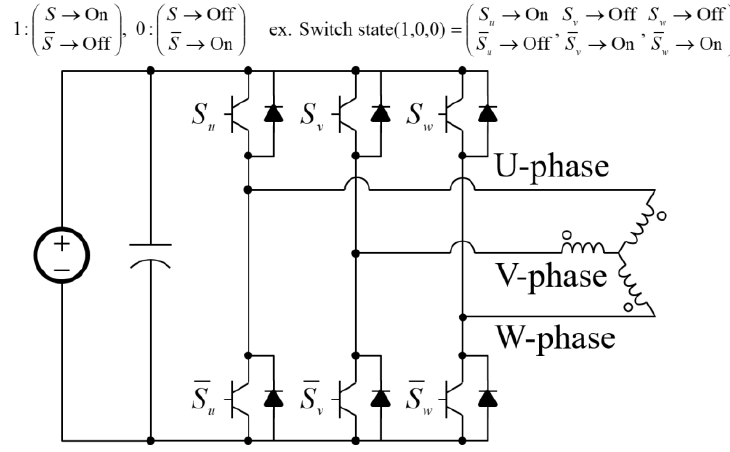
Figure 6. Switch states under three-phase inverter.